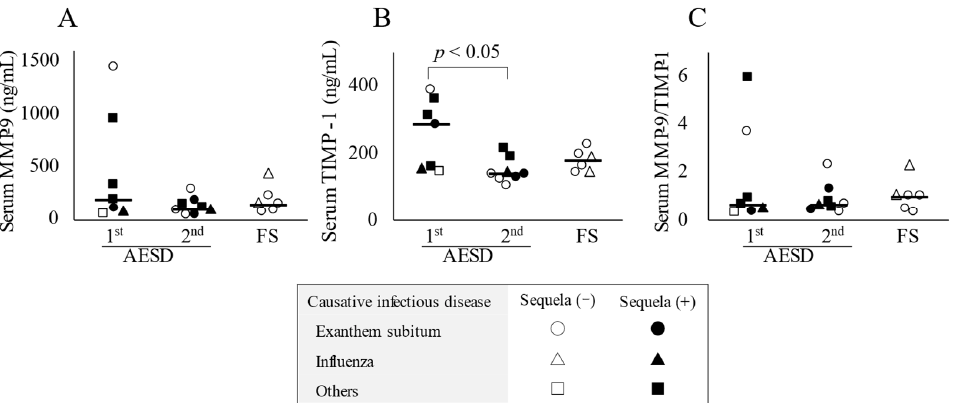
Figure 1. Serum concentrations of biomarkers in patients with acute encephalopathy with biphasic seizures and late reduced diffusion (AESD) in the 1st or 2nd seizure phase or with prolonged febrile seizure (FS). Serum concentrations of matrix metalloproteinase-9 (MMP-9) ( A ) and tissue inhibitor matrix metalloproteinase-1 (TIMP-1) ( B ) and the MMP-9/TIMP-1 ratio in serum ( C ) in all patients with AESD or prolonged FS. The horizontal bar represents the median value. Statistical comparisons by the Tukey–Kramer or Steel–Dwass test. Circles, triangles, and squares represent patients with AESD or FS due to exanthem subitum, influenza, and other infectious diseases, respectively. Filled marks donate patients with sequela (e), and open marks without sequela.